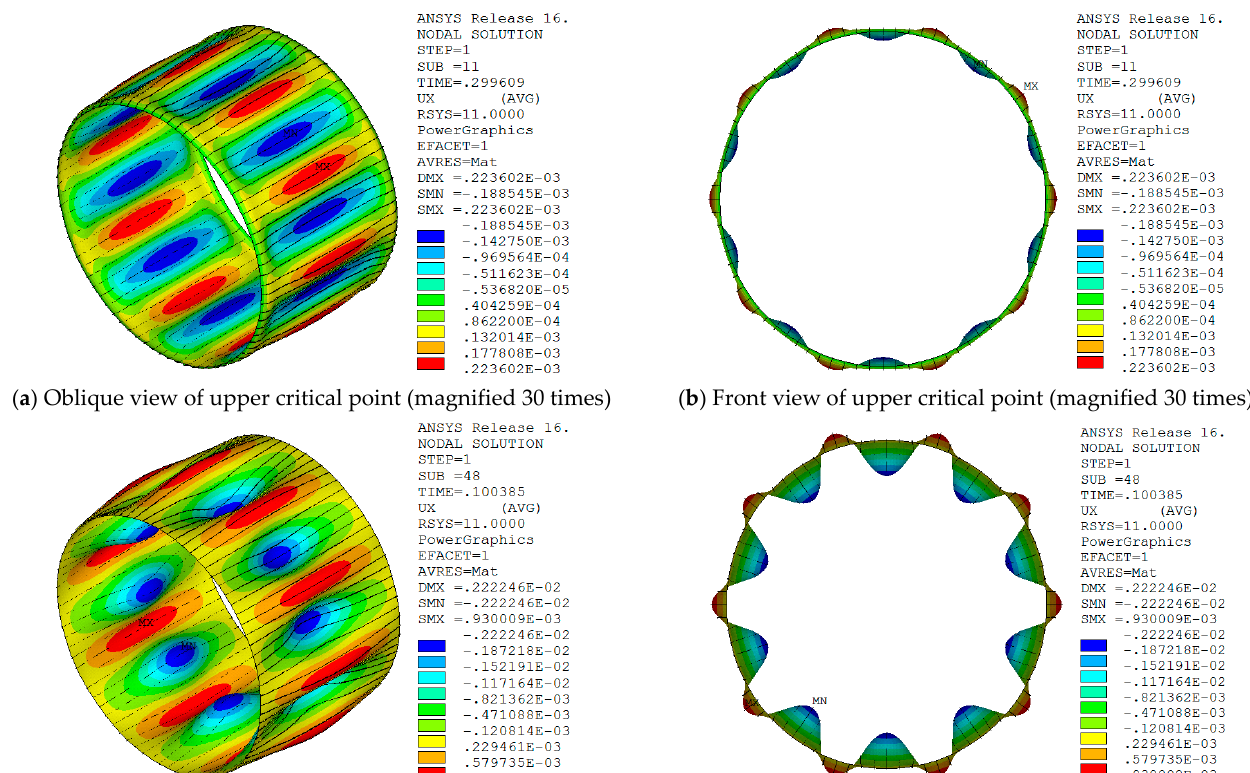
Figure 17. Radial displacement contour map at the critical points of the post-buckling path for the model with the SS3 boundary condition when the material of the model is brass and ξ = 0.1.